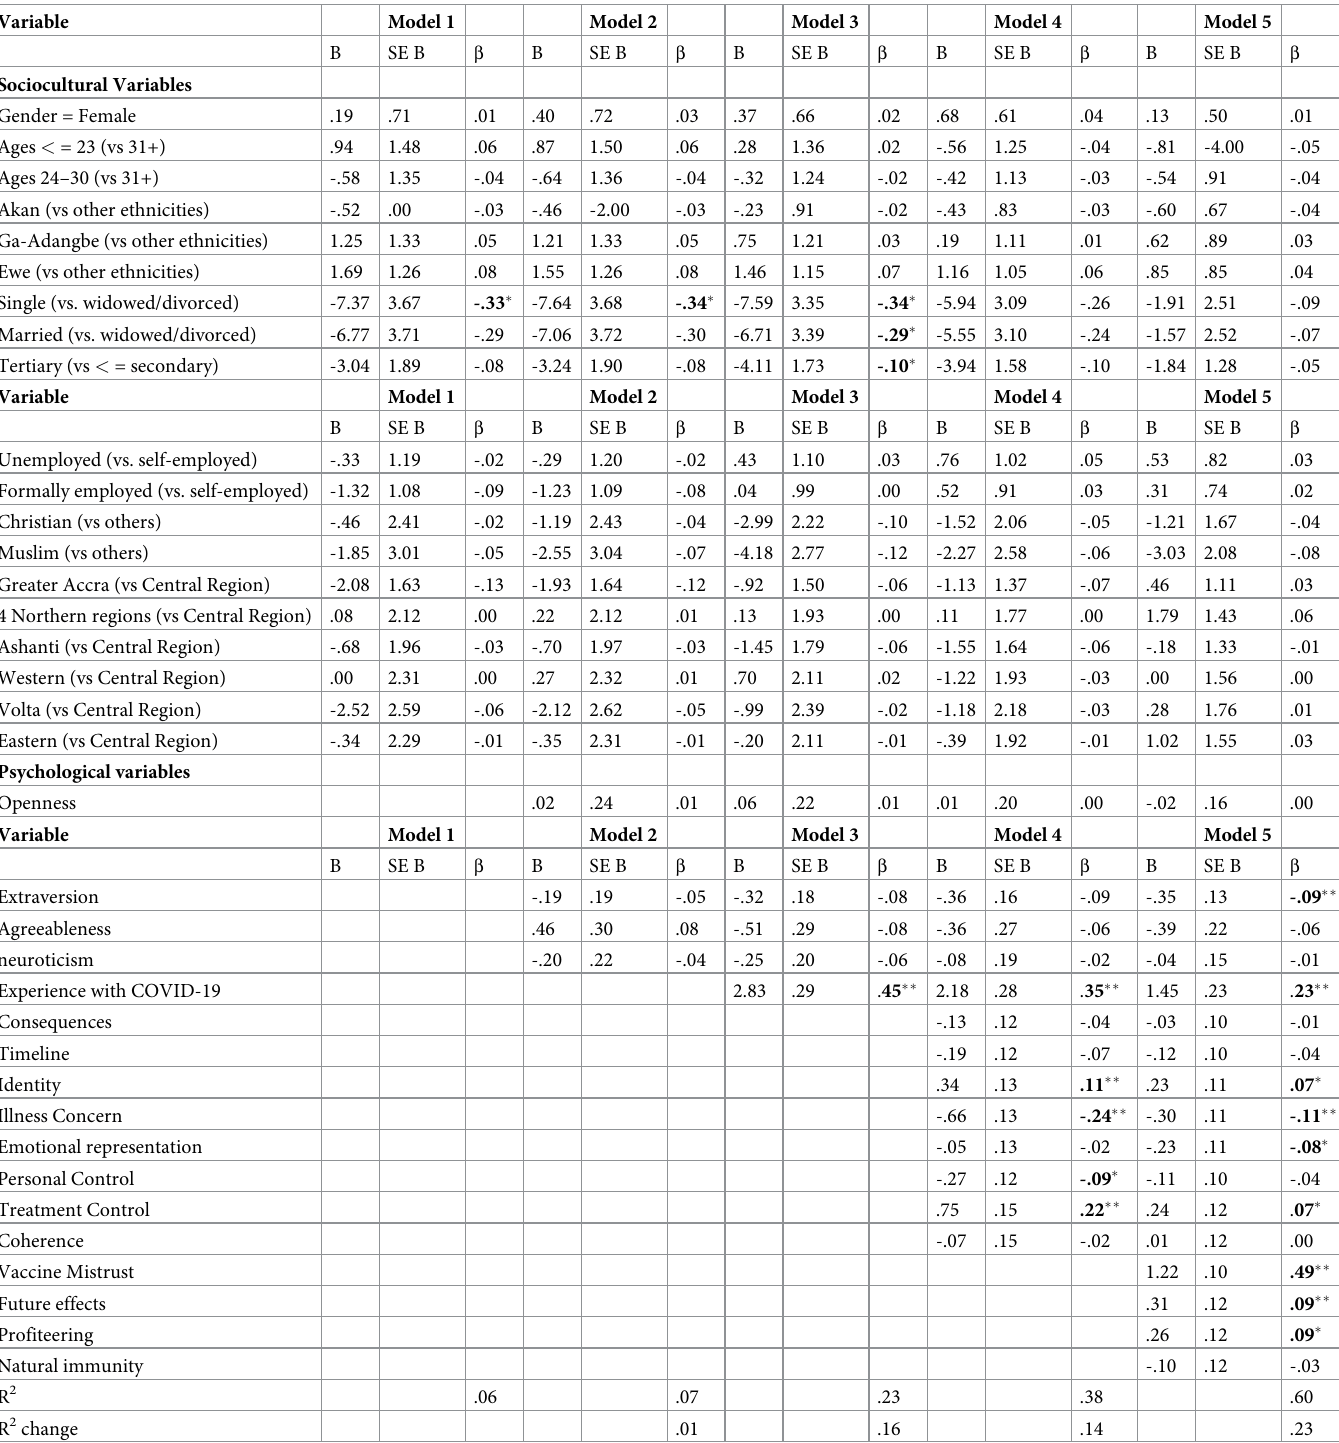
Table 3. Summary of regression